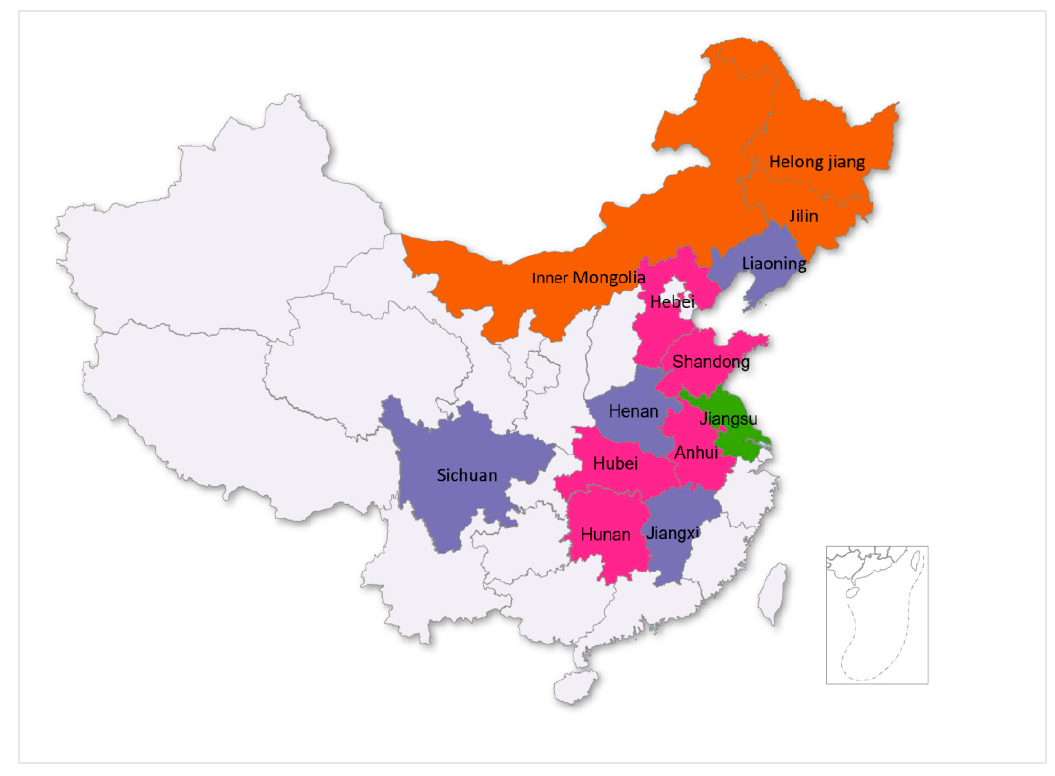
Figure 1. Map of the study area.